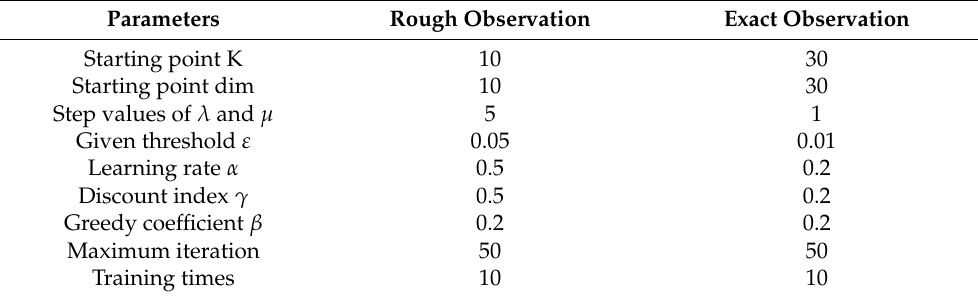
Table 1. Initial parameters of Q-learning for searching.